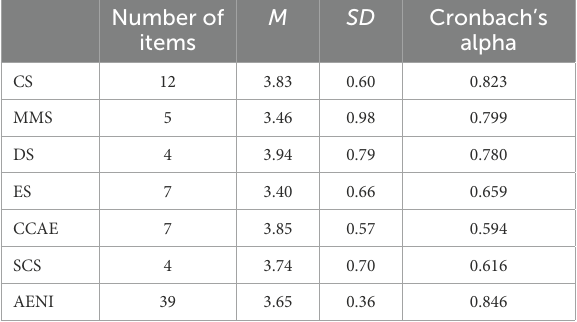
TABLE 1 Accuracy coefficient of the AENI questionnaire measurements ( N =